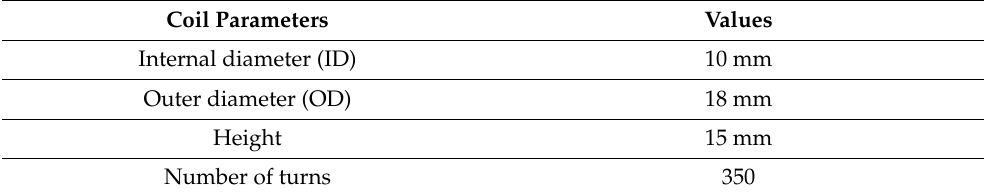
Table 3. The coil parameters used for the computation of inductive reactance.